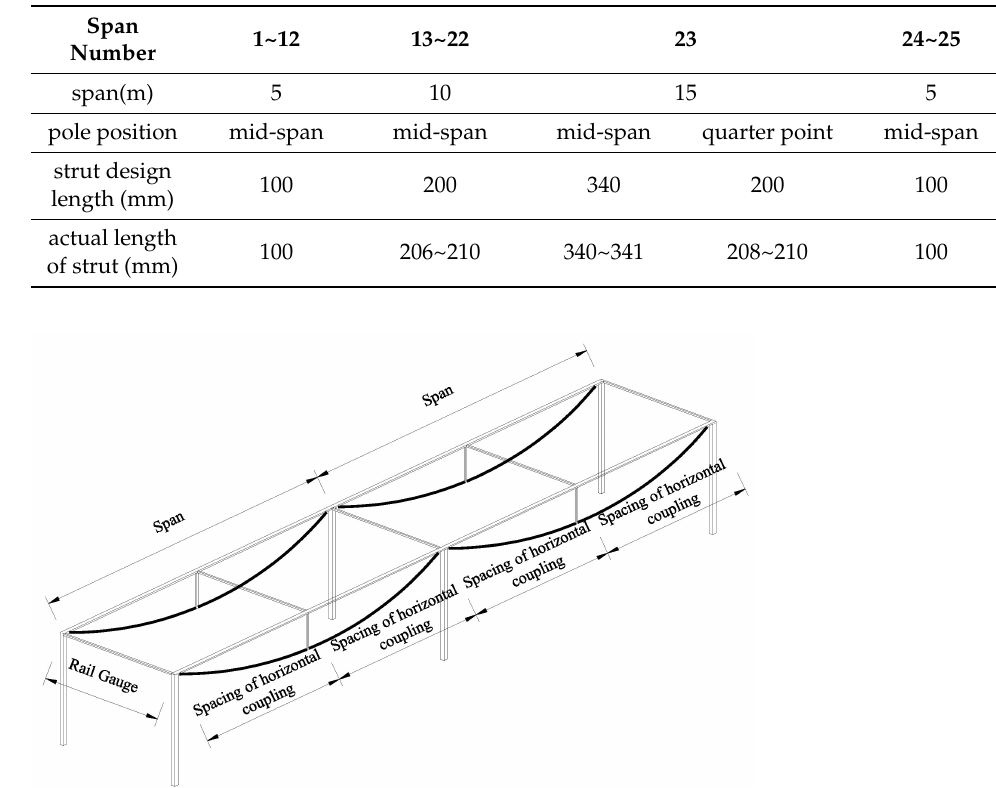
Table 1. Summary of the height of each span strut.